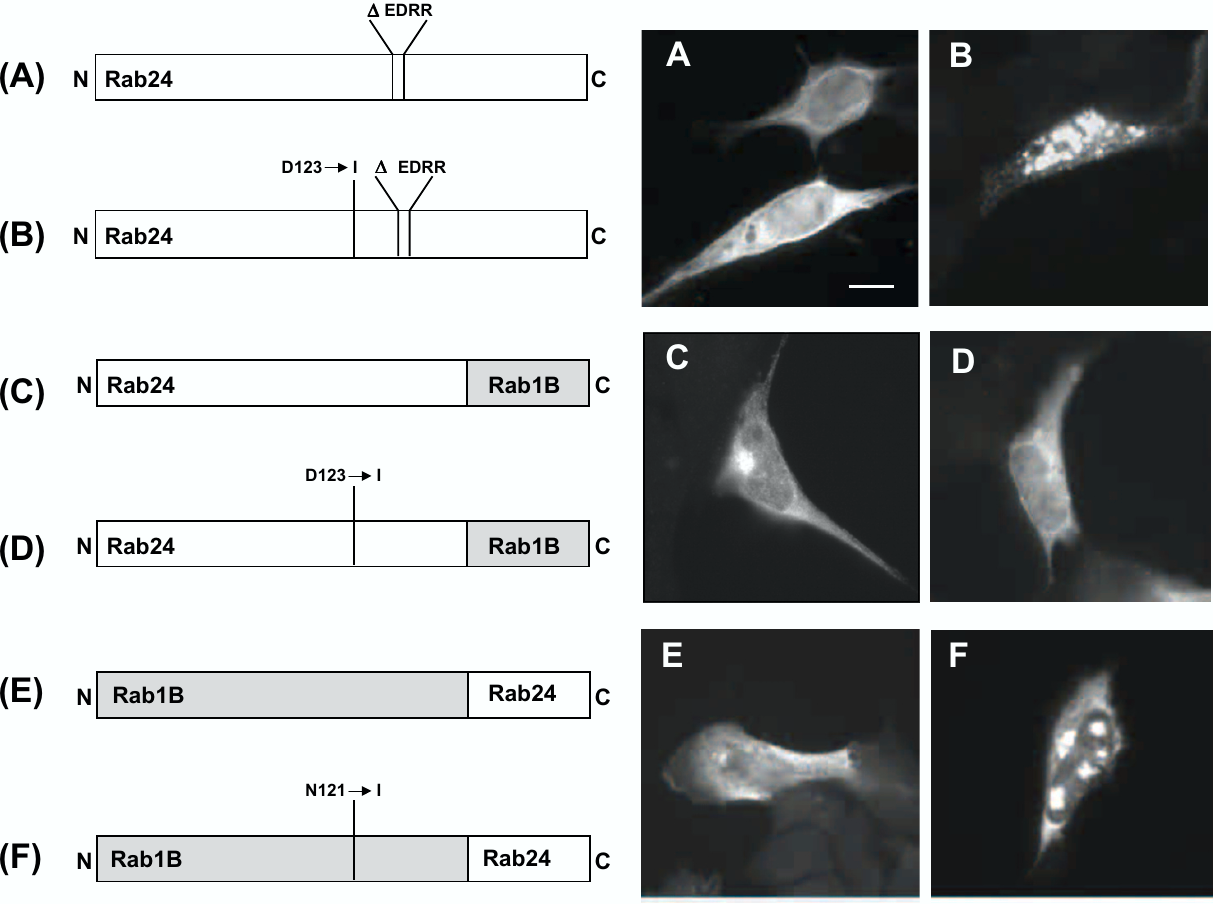
Figure 8 Localization of Rab24 deletion mutants and Rab24/Rab1B chimeras. 293 cells were transfected with expression vec- tors encoding (A,B) Rab24wt or Rab24(D123I), with deletions in the loop-8 insert region, or (C-F) a series of chimeric pro- teins composed of combinations of the N-terminal and C-terminal domains of Rab24 and Rab1B, with or without the D123I substitution (see Methods for detailed descriptions). After 24 h, the transfected cells were processed for immunofluorescence microscopy using the anti-myc monoclonal antibody and FITC-conjugated GAM IgG to localize the expressed proteins. Panels A-F show representative cells from cultures expressing the indicated proteins. The bar represents 10